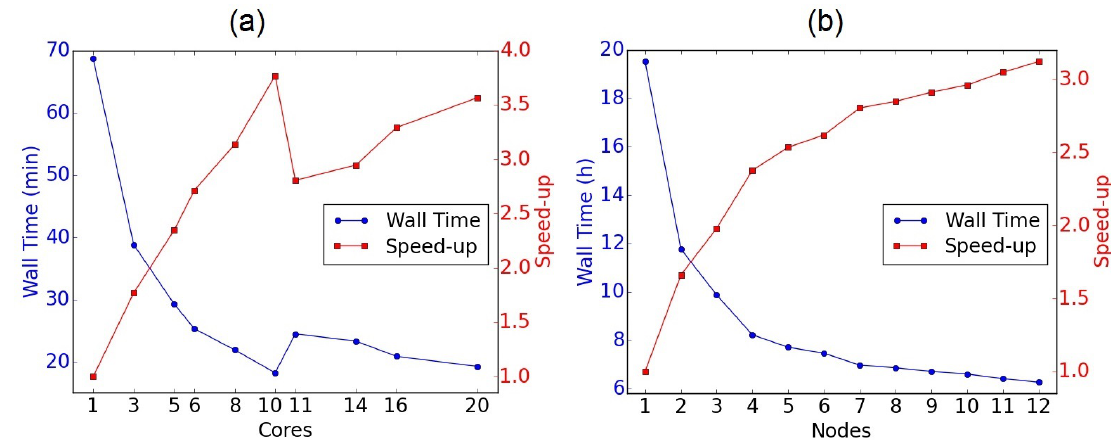
Figure 14. ( a ) Wall time for the first 0.1 ms of the simulation and the speed-up factor versus number of cores within one node. ( b ) Wall time for one oscillation cycle and the speed-up factor versus number of nodes, each with 10 requested physical cores (20